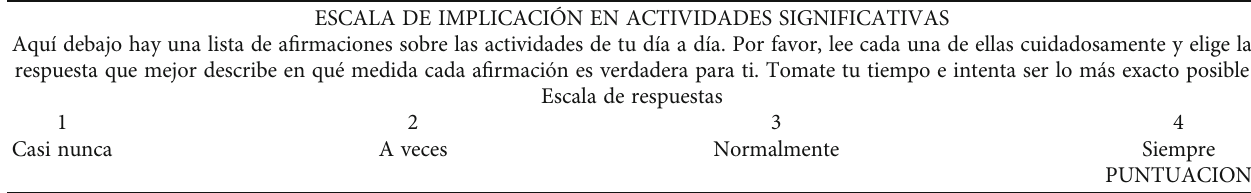
Table 2: Final version of